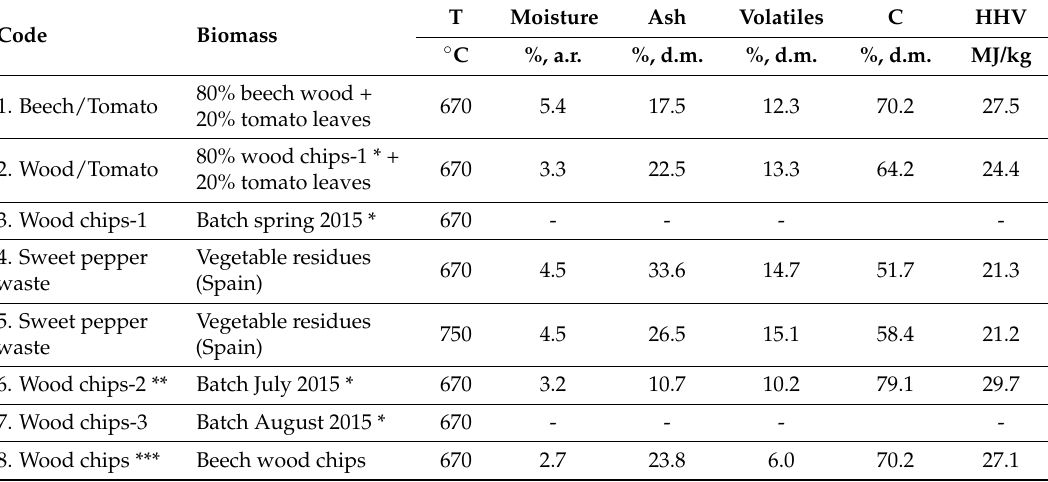
Table 1. Overview of the biochars produced by ECN and pyrolysis